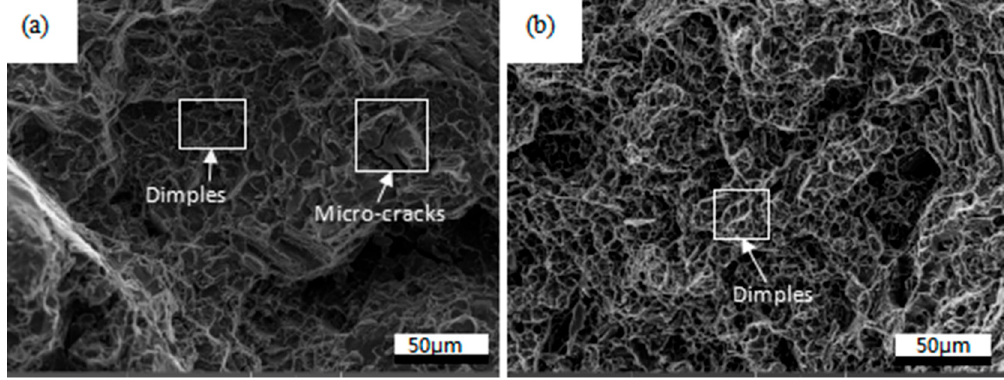
Figure 8. SEM fractography of ECAPed Mg-9Al-1Si-1SiC composites: ( a ) without HT; ( b ) with HT.